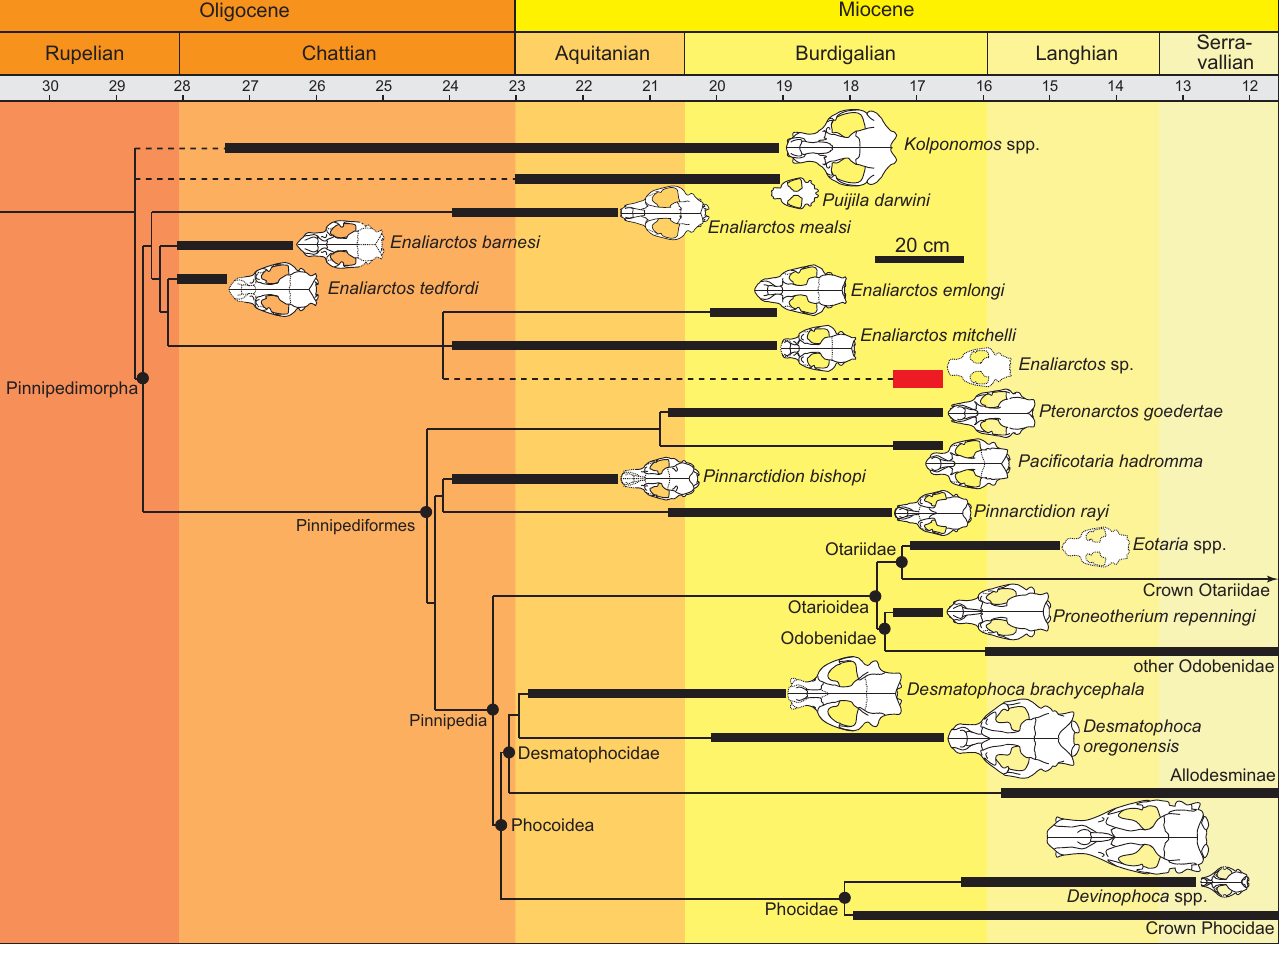
Fig. 8. Time calibrated composite phylogenetic hypothesis of early pinnipedimorphs and putative allies, with an emphasis on Oligo-Miocene pinnipedi- morphs from the eastern North Pacific. Topology based on Boessenecker and Churchill (2015), except as follows: Enaliarctos from Berta (1991); Phocoidea after Boessenecker and Churchill (in press). Placement of Pacificotaria from Deméré and Berta (2001), conjectural placement (dashed lines) of Puijila and Kolponomos after Tedford et al. (1994) and Rybczynski et al. (2009), Enaliarctos sp. (UWBM 89114) based on shared dental synapomorphies with E . emlongi and E . mitchelli . Geochronologic ranges from Table 3 (this study), Boessenecker and Churchill (2015: supplementary information, in press: supplementary information), and Rybczynski et al.